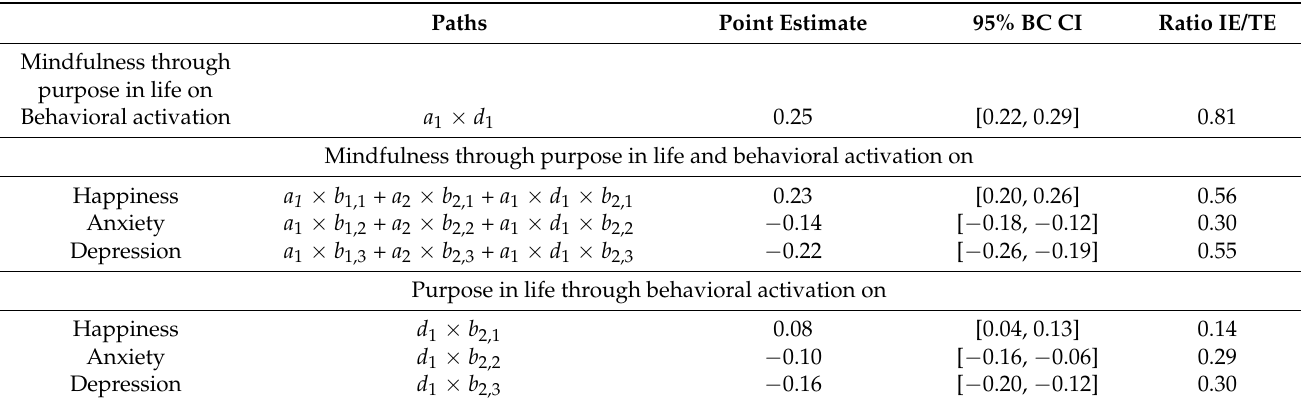
Table 4. Standardized indirect effects of mindfulness and purpose in life on mediators and outcome